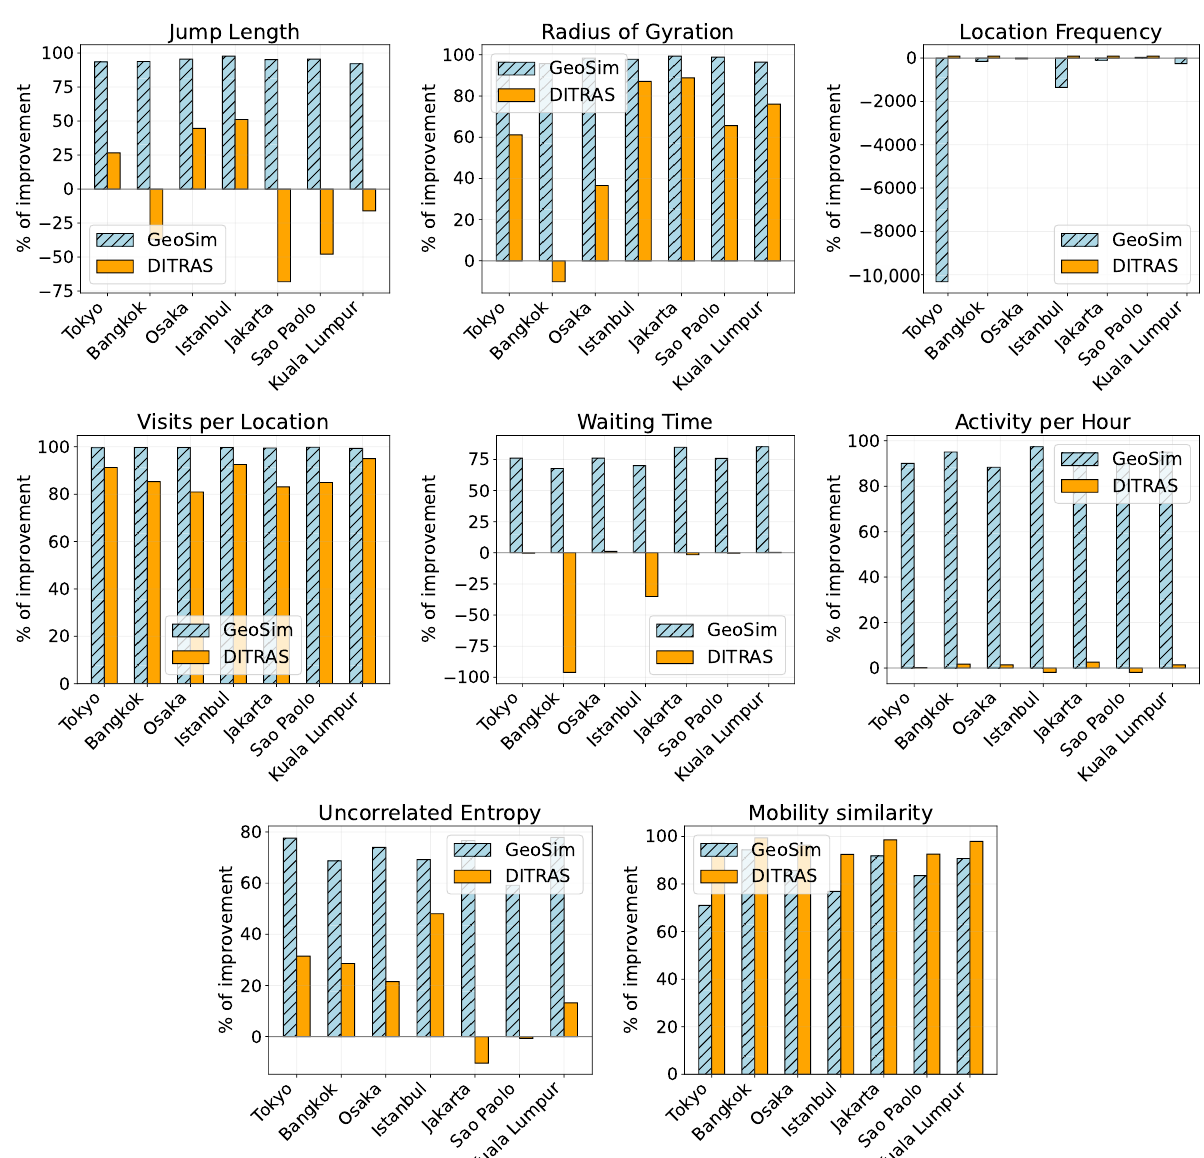
Figure 6. Average improvement in terms of KL divergence (percentage) achieved by using STS-EPR with respect to GeoSim (cyan bars) and DITRAS (orange bars). Note that 100% is an upper bound for the improvement, while there is no lower